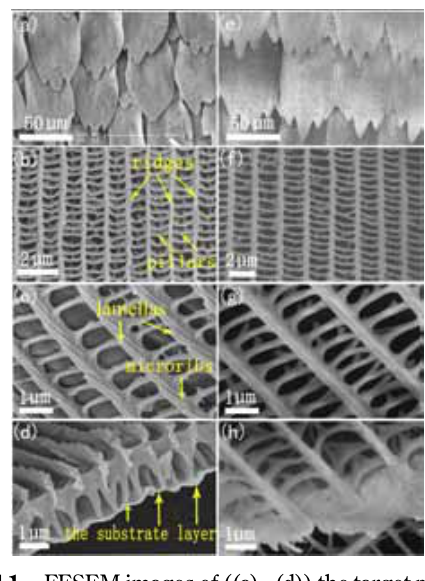
Fig. 11 FESEM images of ((a) - (d)) the target product SnO and ((e) - (h)) the corresponding natural 2 butterfly wings: (a) and (e) well-aligned scales, (b) and (f) part of a single scale, (c) and (g) the detailed structure of the ridges, (d) and (h) the cross section of the scale.